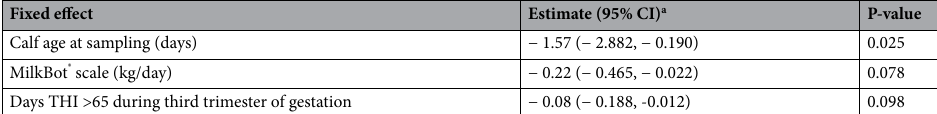
Table 4. Multivariable model for the multiparous dams (n=122), adjusted from the variables that obtained P < 0.15 in the univariable analyses. a Estimates, with 95% confidence interval, presented as a % difference in TL for a 1-unit increase in the explanatory variable. Herd was included as a random factor and the log 10 transformed TL was used as the outcome